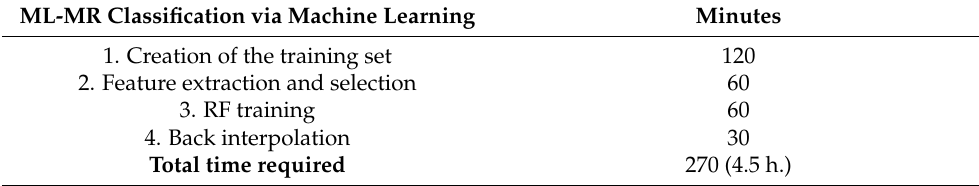
Table 2. Estimate of the ML-MR classification time via RF for a single classification level (in bold the total time